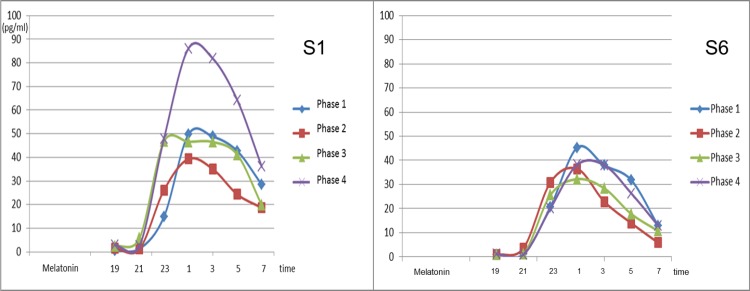
Overnight (7 pm to 7 am) serum melatonin levels.Phase 1: LNAA supplement, Phase 2: Washout, Phase 3: BH4 therapy, Phase 4: BH4 and LNAA. Left: melatonin responder to BH4 (S1), Right: melatonin non-responder to BH4 (S6). Serum melatonin (pg/ml).